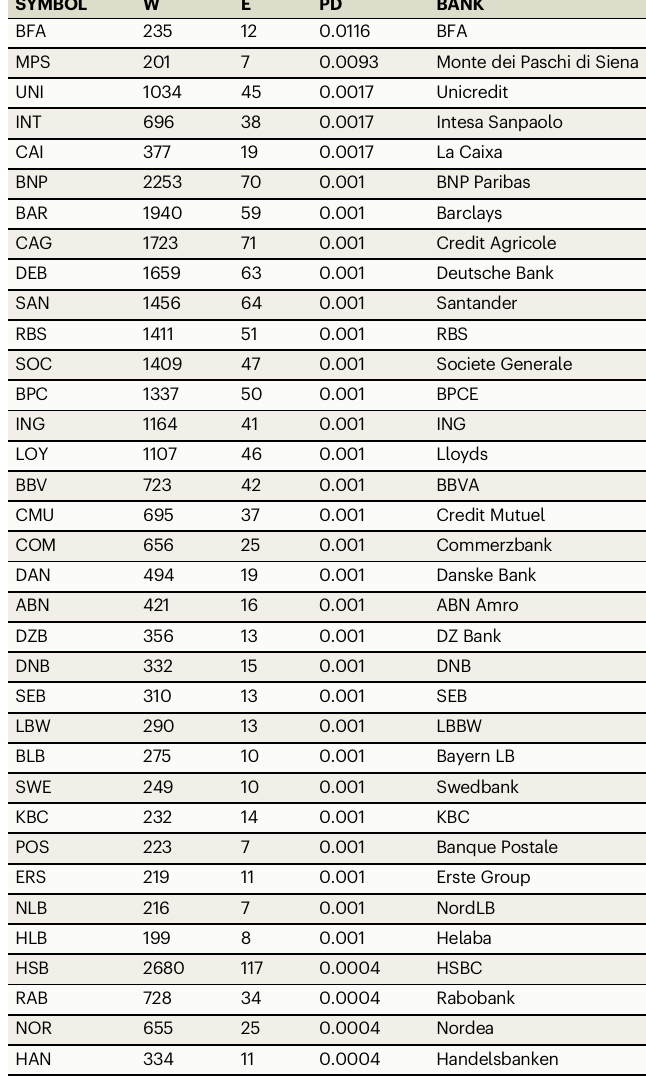
Thetotal asset (W) and Tier 1 capital (E) areexpressed inbillions of EUR. Thedata arefrom the European Banking Authority (EBA) 55 andarerelative totheend of 2014.Theprobabilitiesof default havebeen derivedusingdata from the Fitch credit ratingagency 56